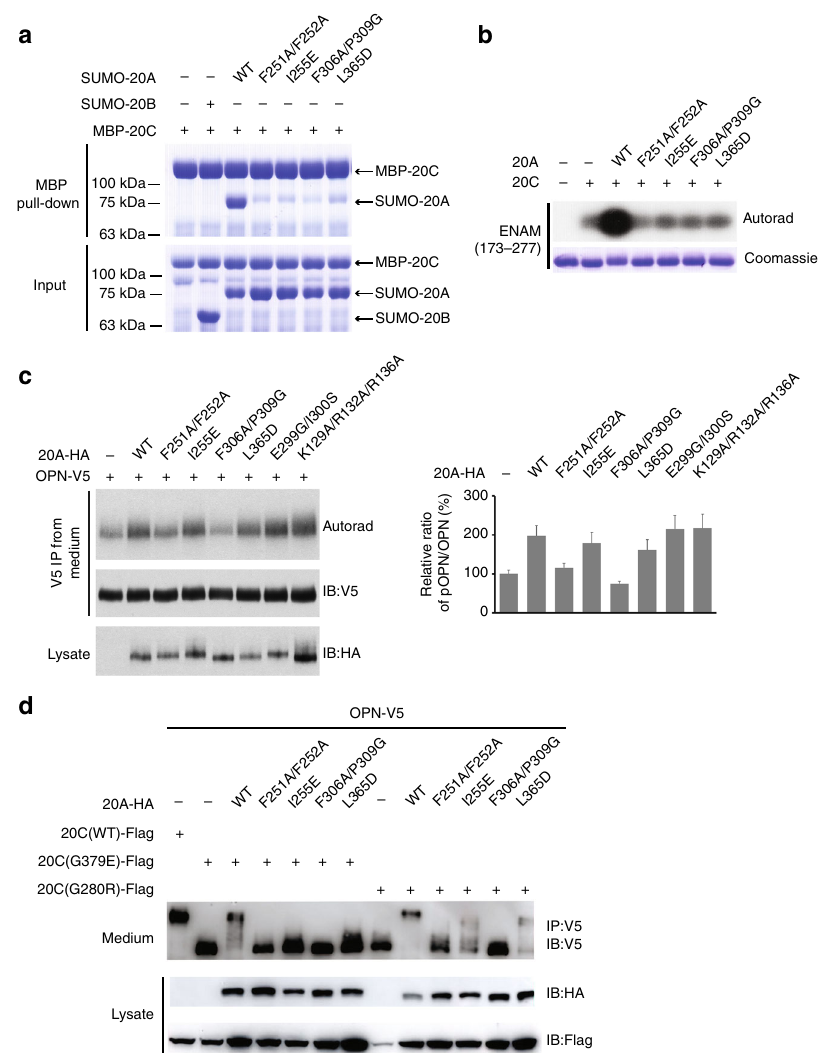
Fig. 2 The dimer interface is critical for Fam20A to bind and activate Fam20C. a Fam20A mutants display reduced interaction with Fam20C. His 6